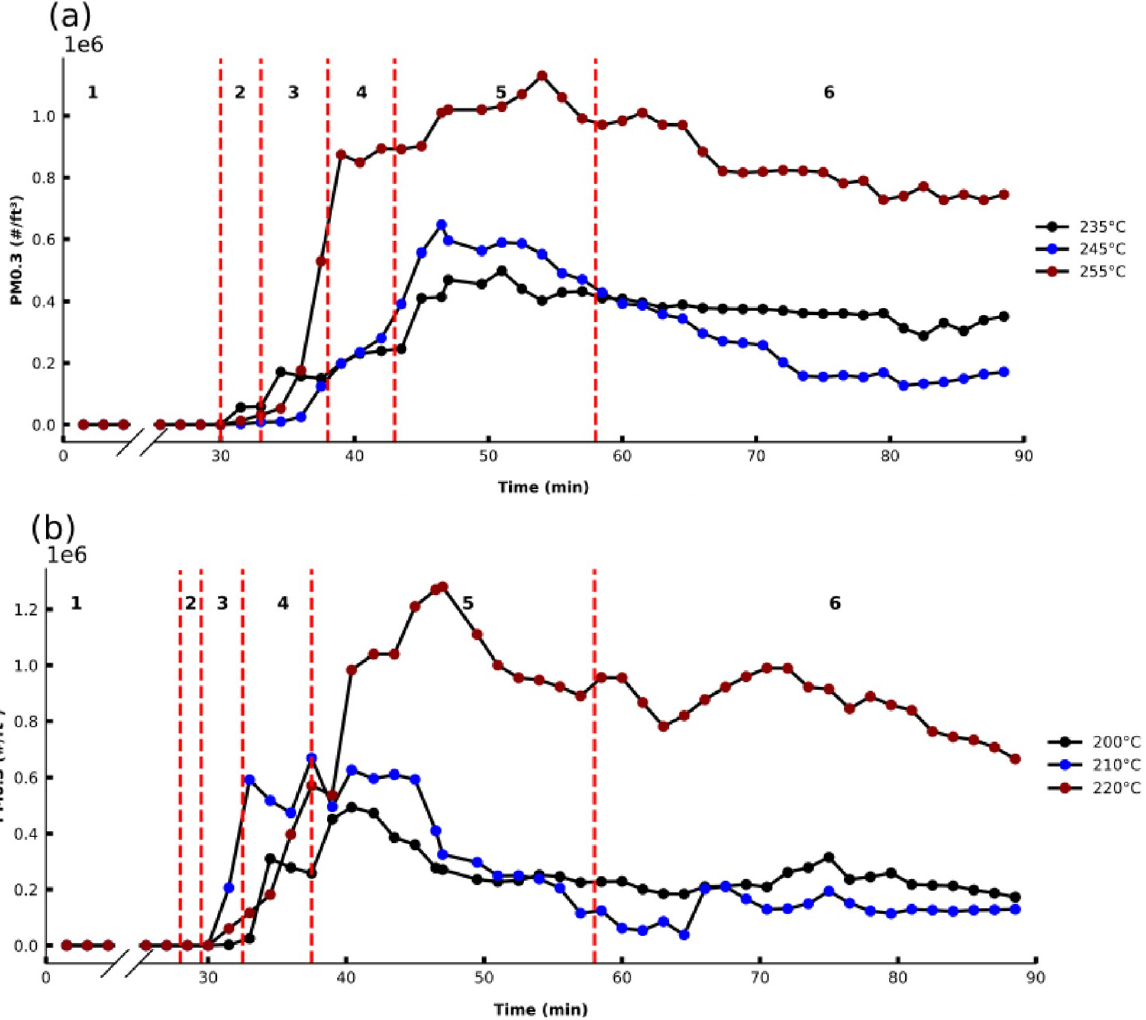
Figure 6. PM 0.3 profiles for different extruder temperatures over time before, during, and after printing of a cube for ( a ) ABSB1b (bed plate temp: 80 °C, 0% fan, 20% infill) and ( b ) PLAB1b (bed plate temp: 50 °C, 20% fan, 20% infill).